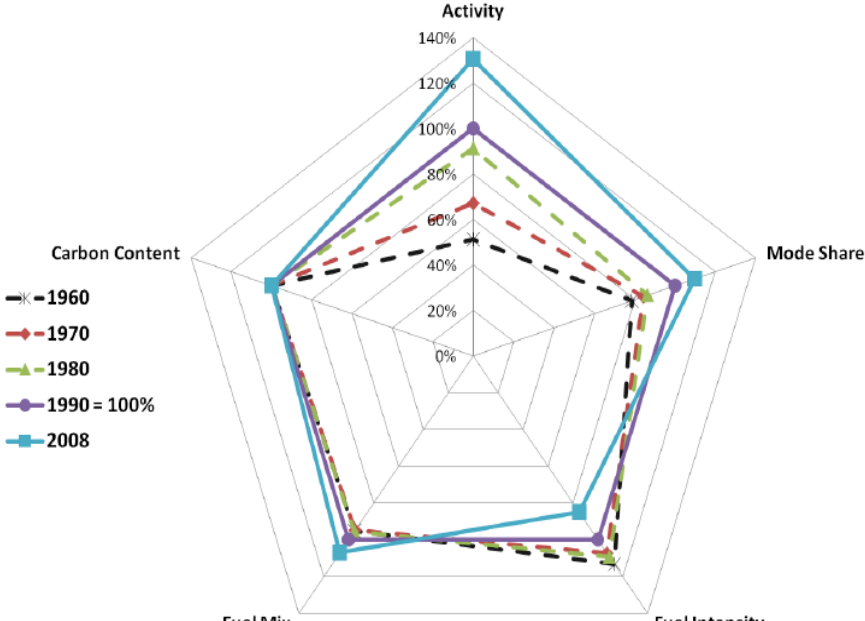
Figure 11. LMDI decomposition results for